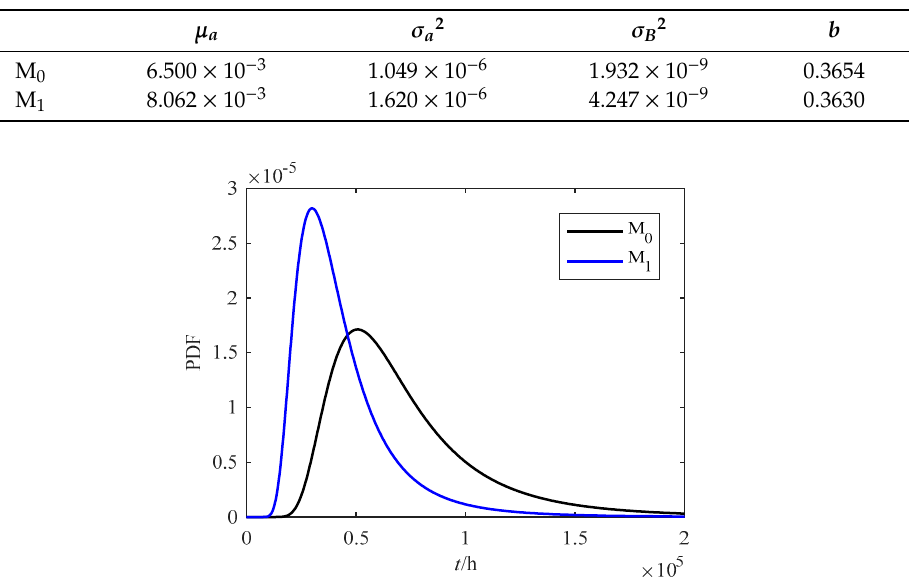
Table 10. Distribution parameters of lifetime under each accelerated stress based on three methods for O-type rubber seal rings.